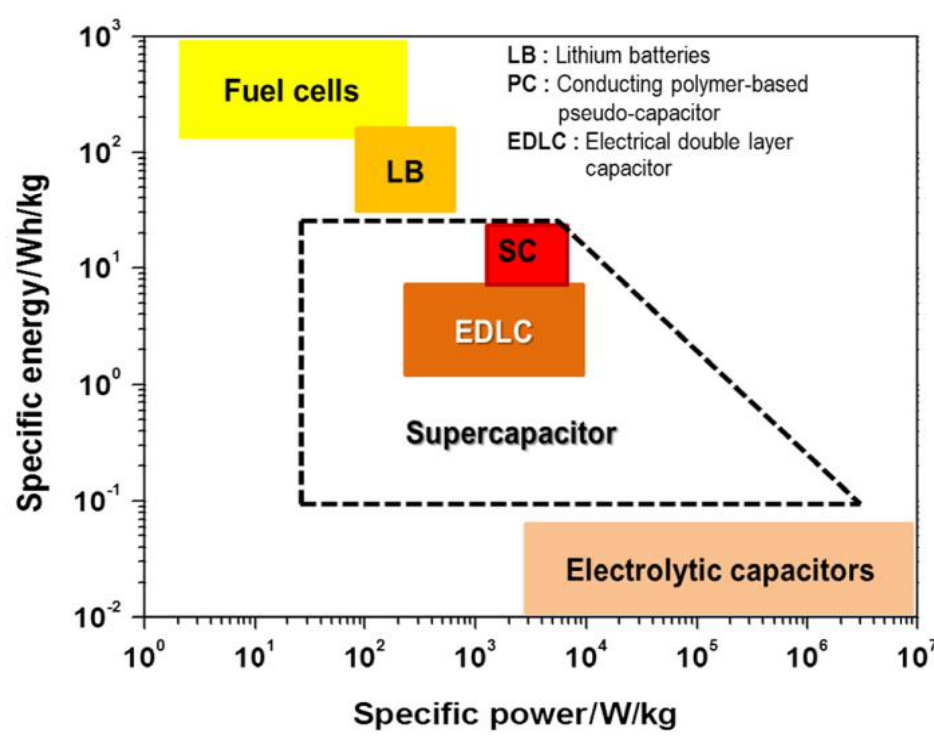
Figure 1. Ragone plot comparison of various energy storage technologies for energy vs. power density [21].